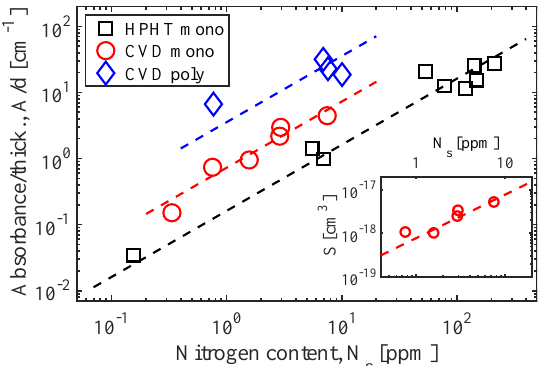
Figure 3. Dependence of diamond substrate absorbance (optical density) per unit depth on the nitrogen concentration. The measurements were performed at a pump wavelength of 400 nm. Dashed lines are linear fittings. The insert shows the optical scattering factor S for monocrystalline CVD diamonds (see text for